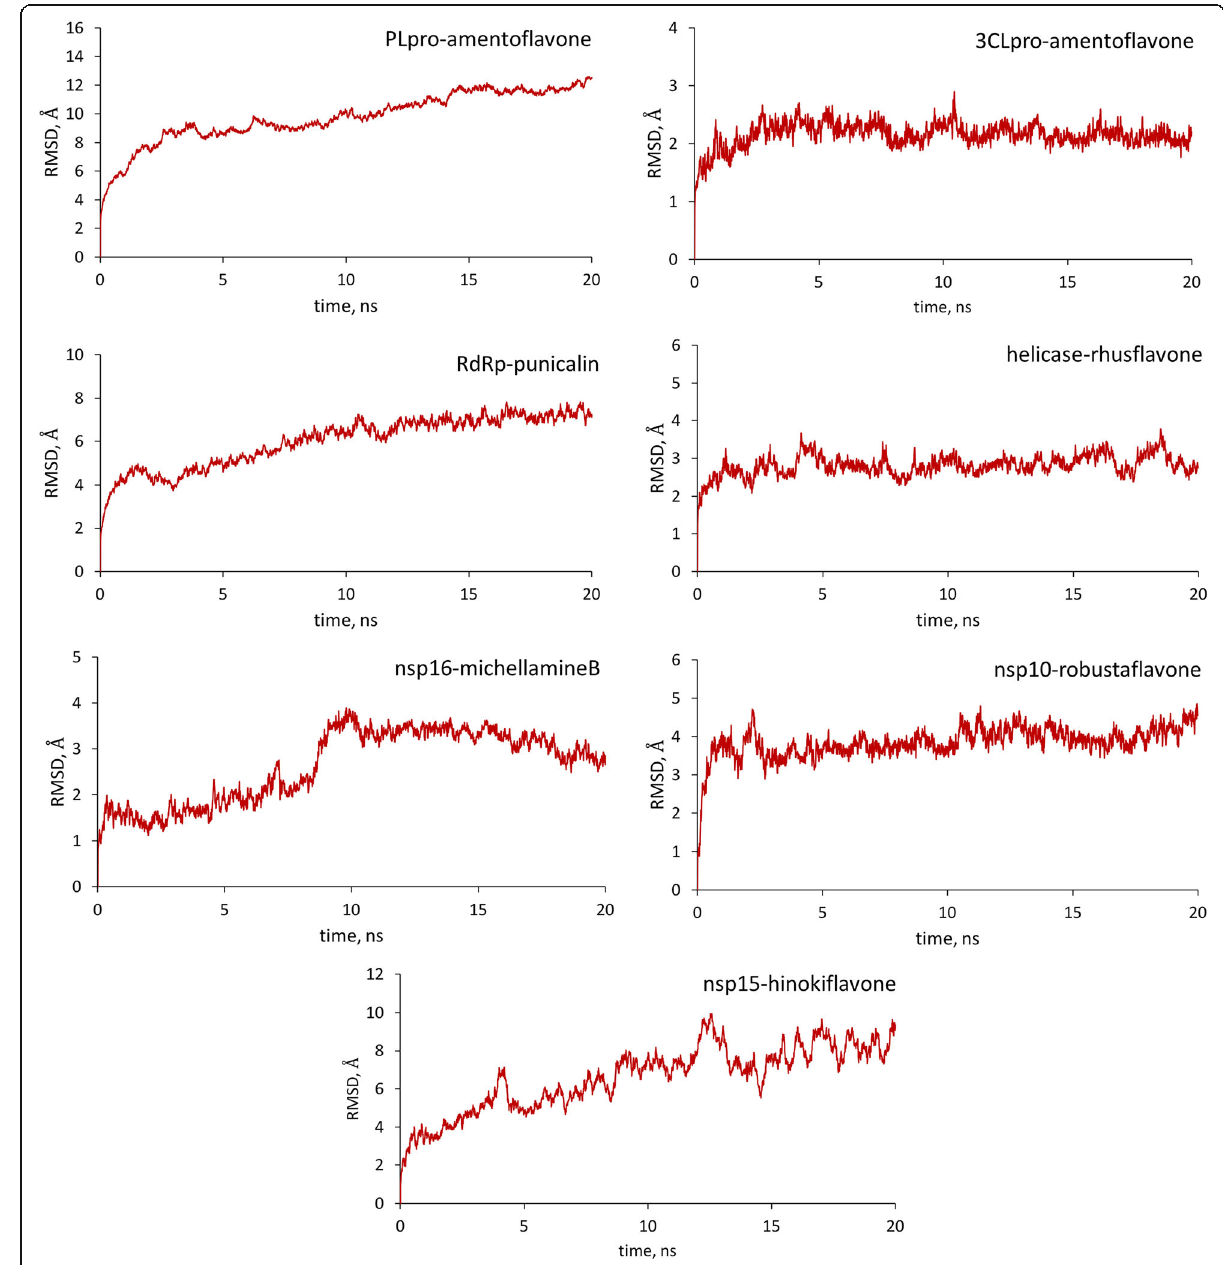
Fig. 5 Root mean square deviation (RMSD, Å) as a function of time of the top-binding